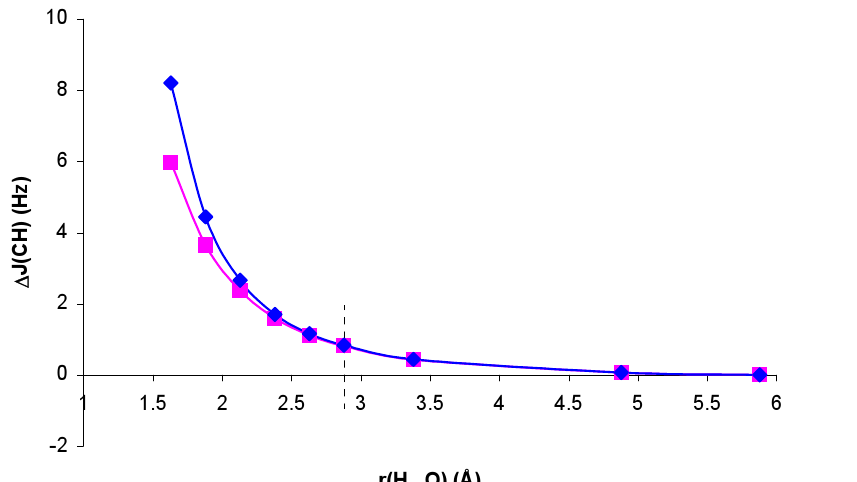
Figure 4. Geometric change in 1 J(CH) for the CH molecule with the complex geometry, ∆ J G , with 4 respect to 1 J(CH) for the isolated CH molecule, as a function of the H...O distance, r(H...O). - (cid:88) - ∆ J G 4 (RPA), - (cid:81) - ∆ J G (SOPPA). The dotted line indicates the equilibrium